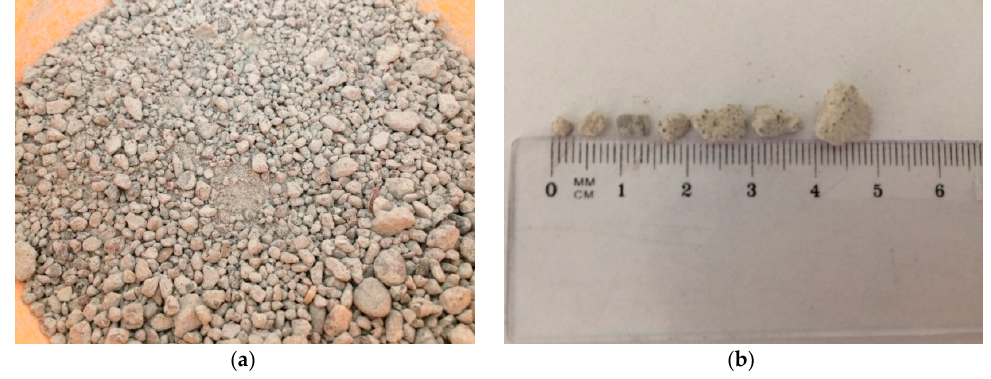
Figure 1. Coarse aggregates for RCA with a size less than 8.0 mm. ( a ) Coarse aggregates; ( b ) particle size.